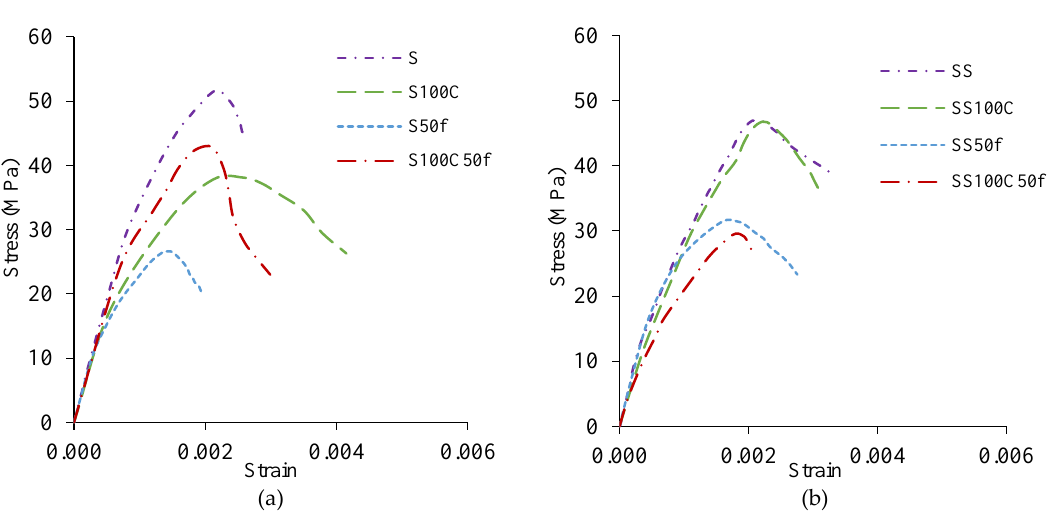
Figure 11. Compressive stress-strain curves for ( a ) Series I, ( b ) Series II.